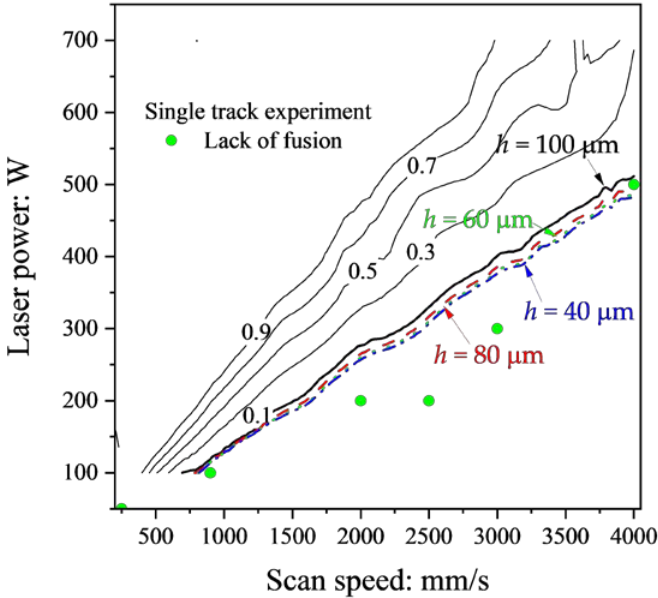
Figure 12. The contour lines of D ov / t using h = 100 µ m (black) and the isolines of D ov / t = 0.1 using h = 100 µ m (black, bold), 80 µ m (red), 60 µ m (green), and 40 µ m (blue) obtained by the FEM analysis and the classification of the lack of fusion of the single-track experiments.